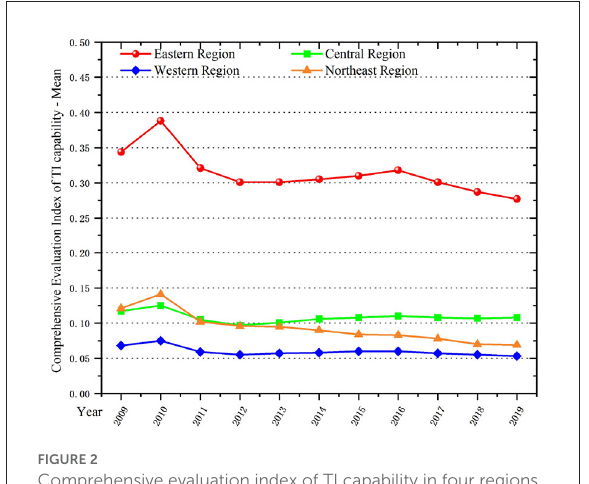
FIGURE3 Comprehensive evaluation index of NU level in four regions of China, 2009–2019.